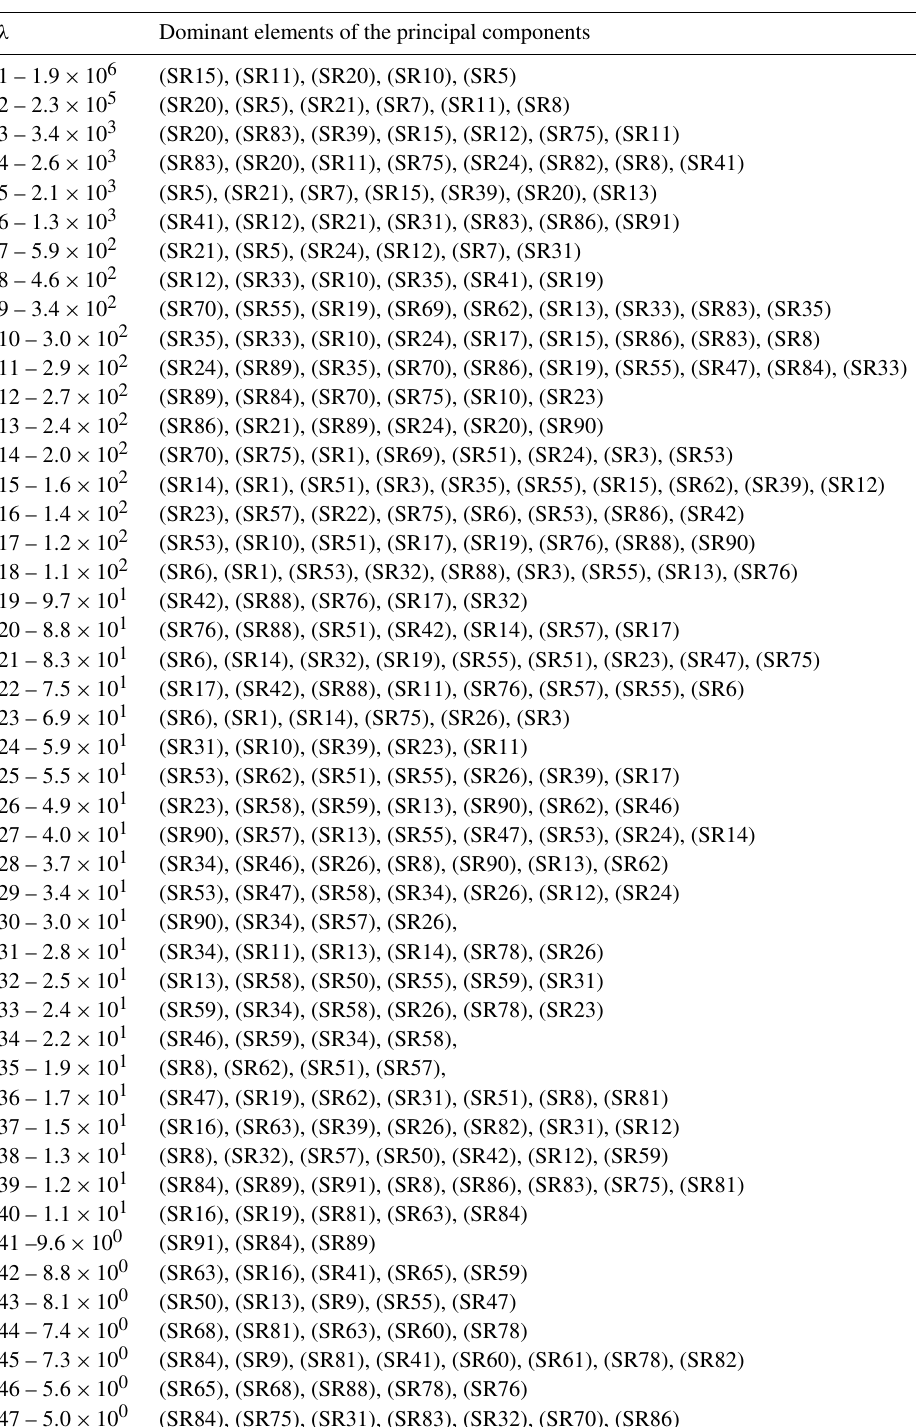
T Table 4. Eigenvalues ( λ ) and the corresponding principal components of e S e S for the original reaction mechanism of the ODE. The first number in the column of λ refers to the number of the eigenvalue, and the value after the hyphen gives the value of λ . Here only the principal components with eigenvalues larger than 0.3572 are listed. Within each principal component, elements larger than 0.2 are